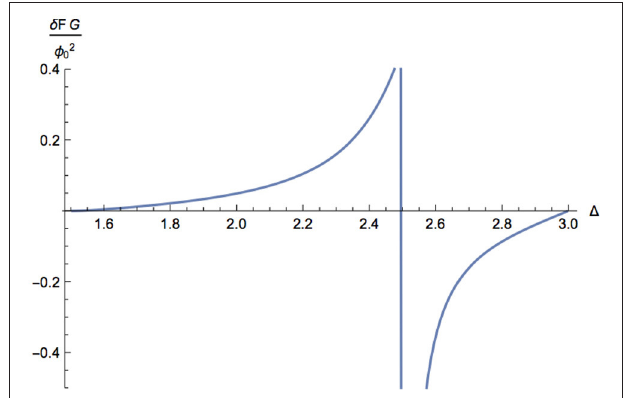
FIGURE 1 | The change in the renormalized free energy, normalized by G N /φ 2 (0) , for 3 2 < 1 < 3.